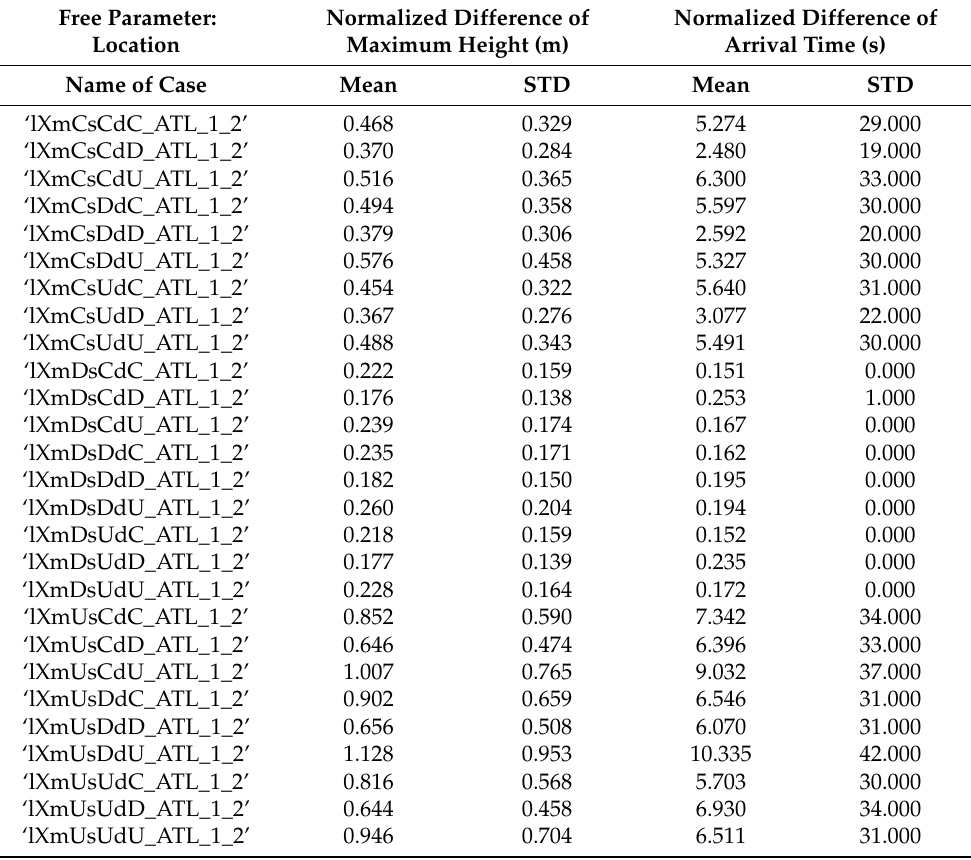
Table A5. Mean normalized difference of maximum height and of arrival time for scenarios with varying source